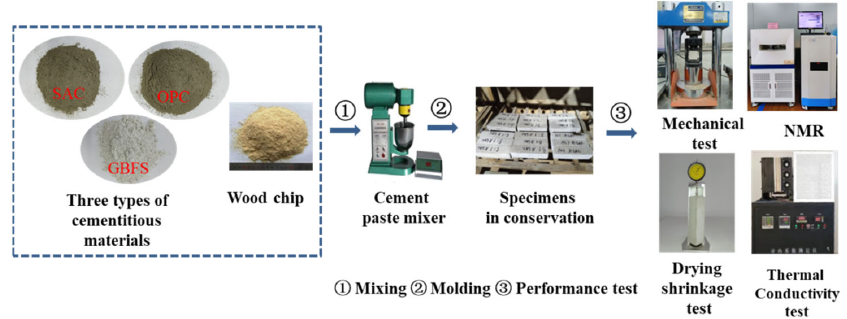
Figure 3. Preparation and experimental process of the specimens.